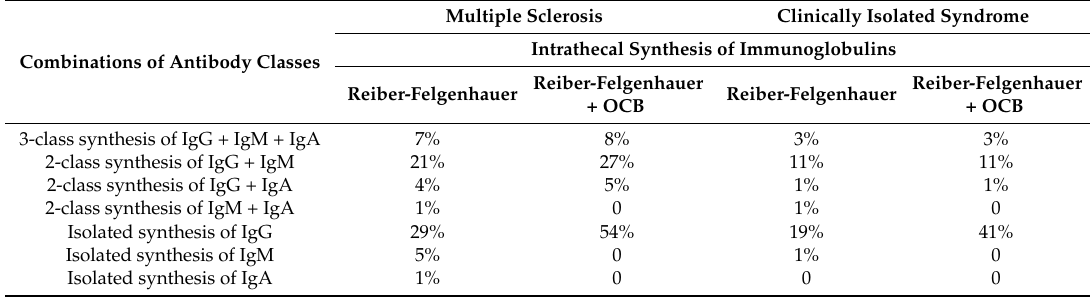
Table 2. Different combinations of intrathecal synthesis of immunoglobulins IgG, IgM, and IgA. Multiple Sclerosis Clinically Isolated Syndrome Intrathecal Synthesis of Immunoglobulins Combinations of Antibody Classes Reiber-Felgenhauer Reiber-Felgenhauer Reiber-Felgenhauer Reiber-Felgenhauer + OCB +